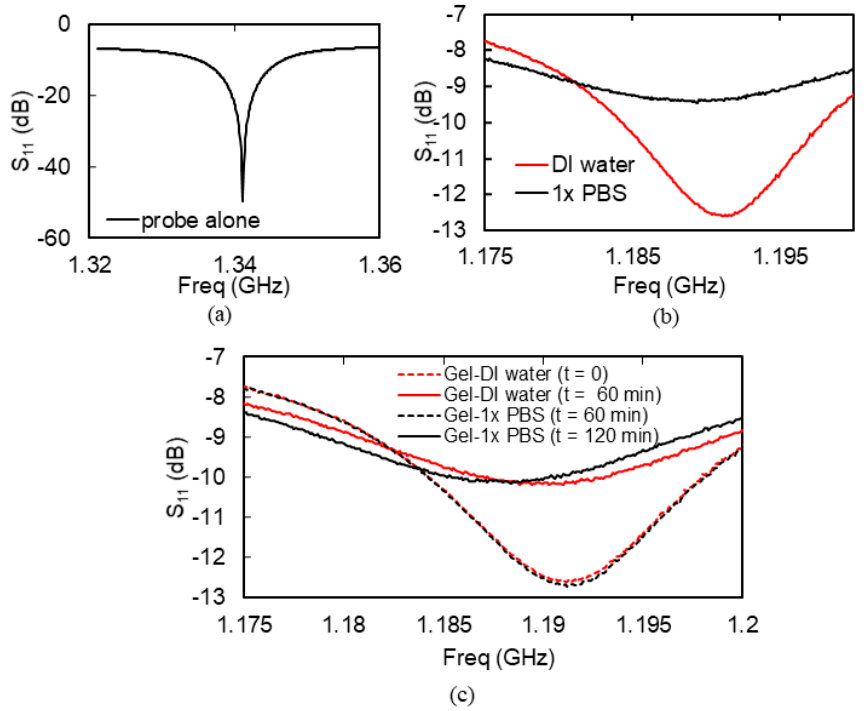
Figure 9. Microwave reflection spectra of the microwave probe. ( a ) Spectrum of the microwave probe with no hydrogel or analyte; ( b ) Spectrum of the microwave probe with analyte but no hydrogel; ( c ) Spectra of the microwave probe with hydrogel for different analytes at different times.